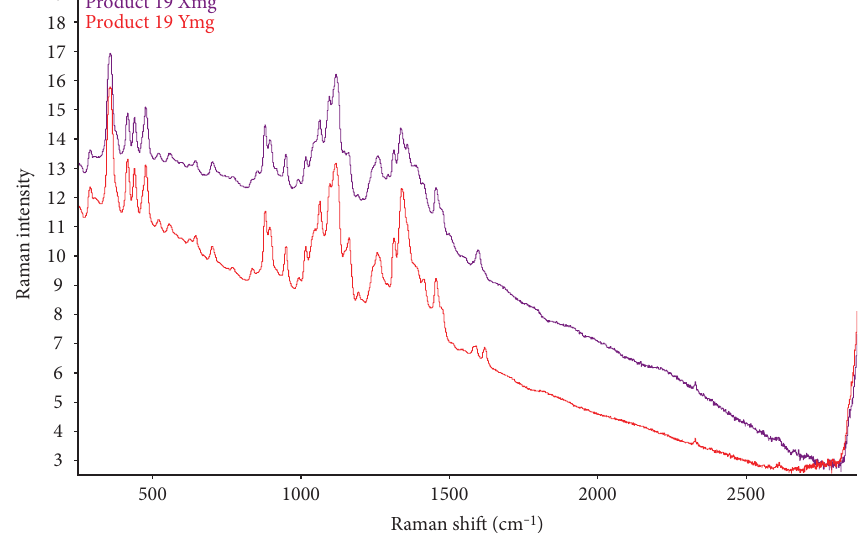
Figure 1: Raman spectra of two dosages of the same product family (product 19). Due to di ff erences in the formulation, the product presents heterogeneous